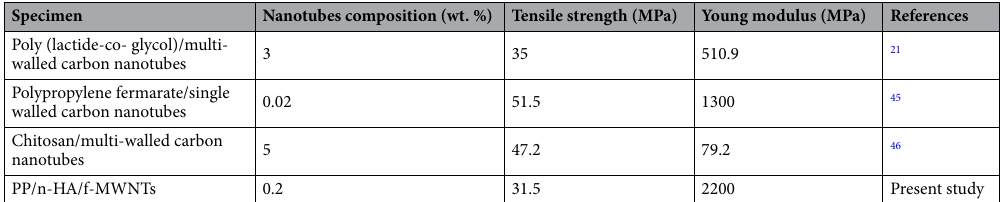
Table 2. Comparison of tensile and Young’s modulus of different nanocomposites.